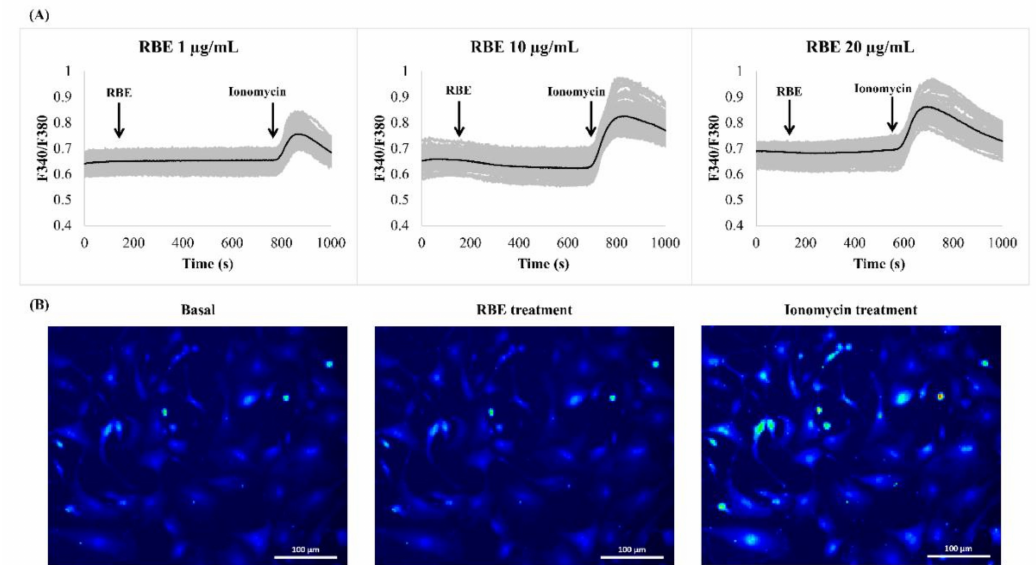
Figure 3. E ff ect of Riceberry rice extract (RBE) on intracellular calcium signals in 3T3-L1 cells. ( A ) Stimulation of cells with RBE 1, 10, and 20 µ g / mL concentrations failed to induce calcium signals compared to 1 µ M ionomycin as a positive control. Black lines represent average traces from all cells. Grey lines represent individual cell recordings. ( B ) Fluorescence emission from cells prior to, during RBE, and ionomycin treatments. Scale bars are 100 µ